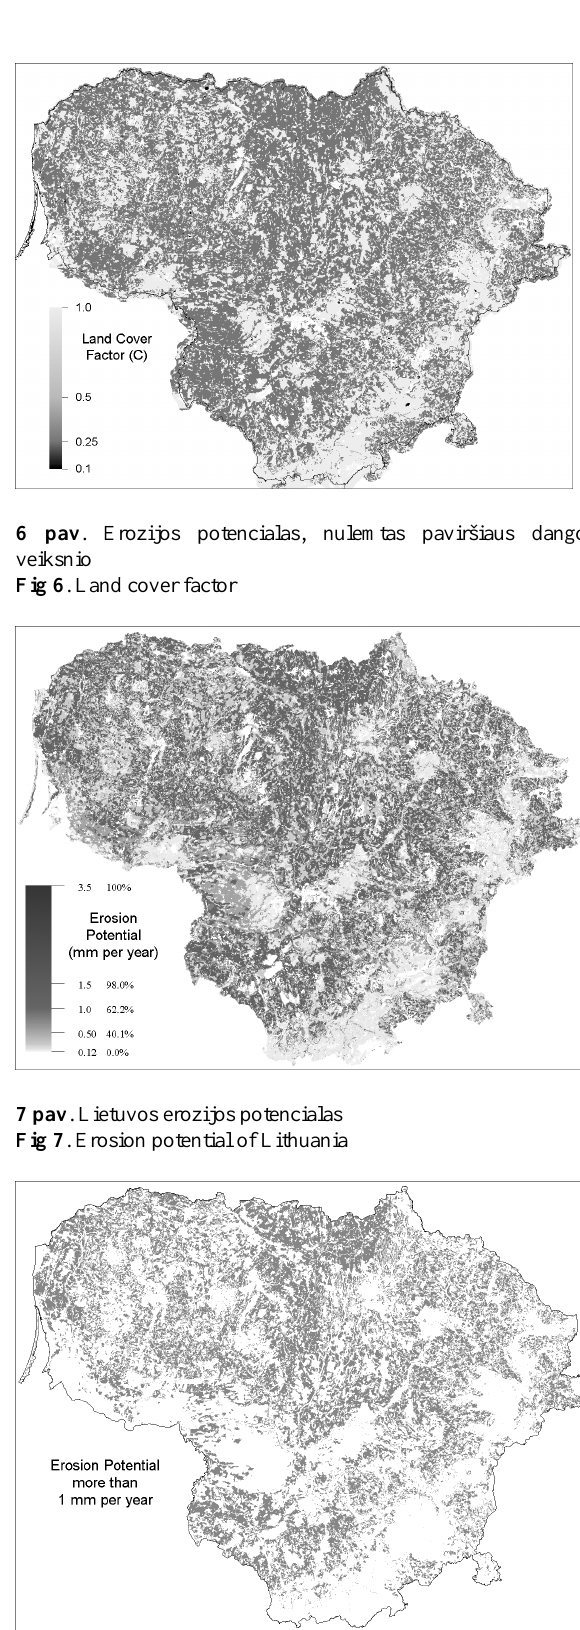
Fig 5 . Erosion potential, considered by topography factor